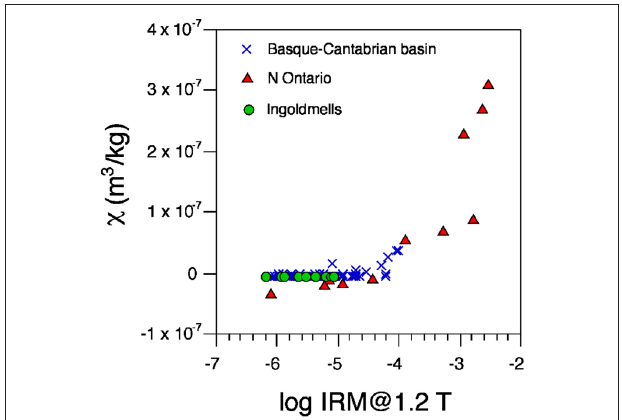
FIGURE 5 | Plot showing the log of the IRM@1.2T vs. magnetic susceptibility of the studied samples from the Basque-Cantabrian basin and their comparison with data from N Ontario (Canada) and Ingoldmells (UK) ( Borradaile et al.,